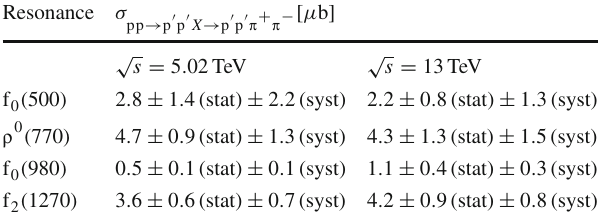
Table 5 Cross sections of the resonant processes in the p T ( π ) > 0 . 2GeV , | η( π ) | < 2 . 4 fiducial region, extracted from the simple model fit using the sum of the continuum distribution obtained from the dime mc model and four dominant resonances. The luminosity-related uncer- tainties are included in the systematic uncertainties. The